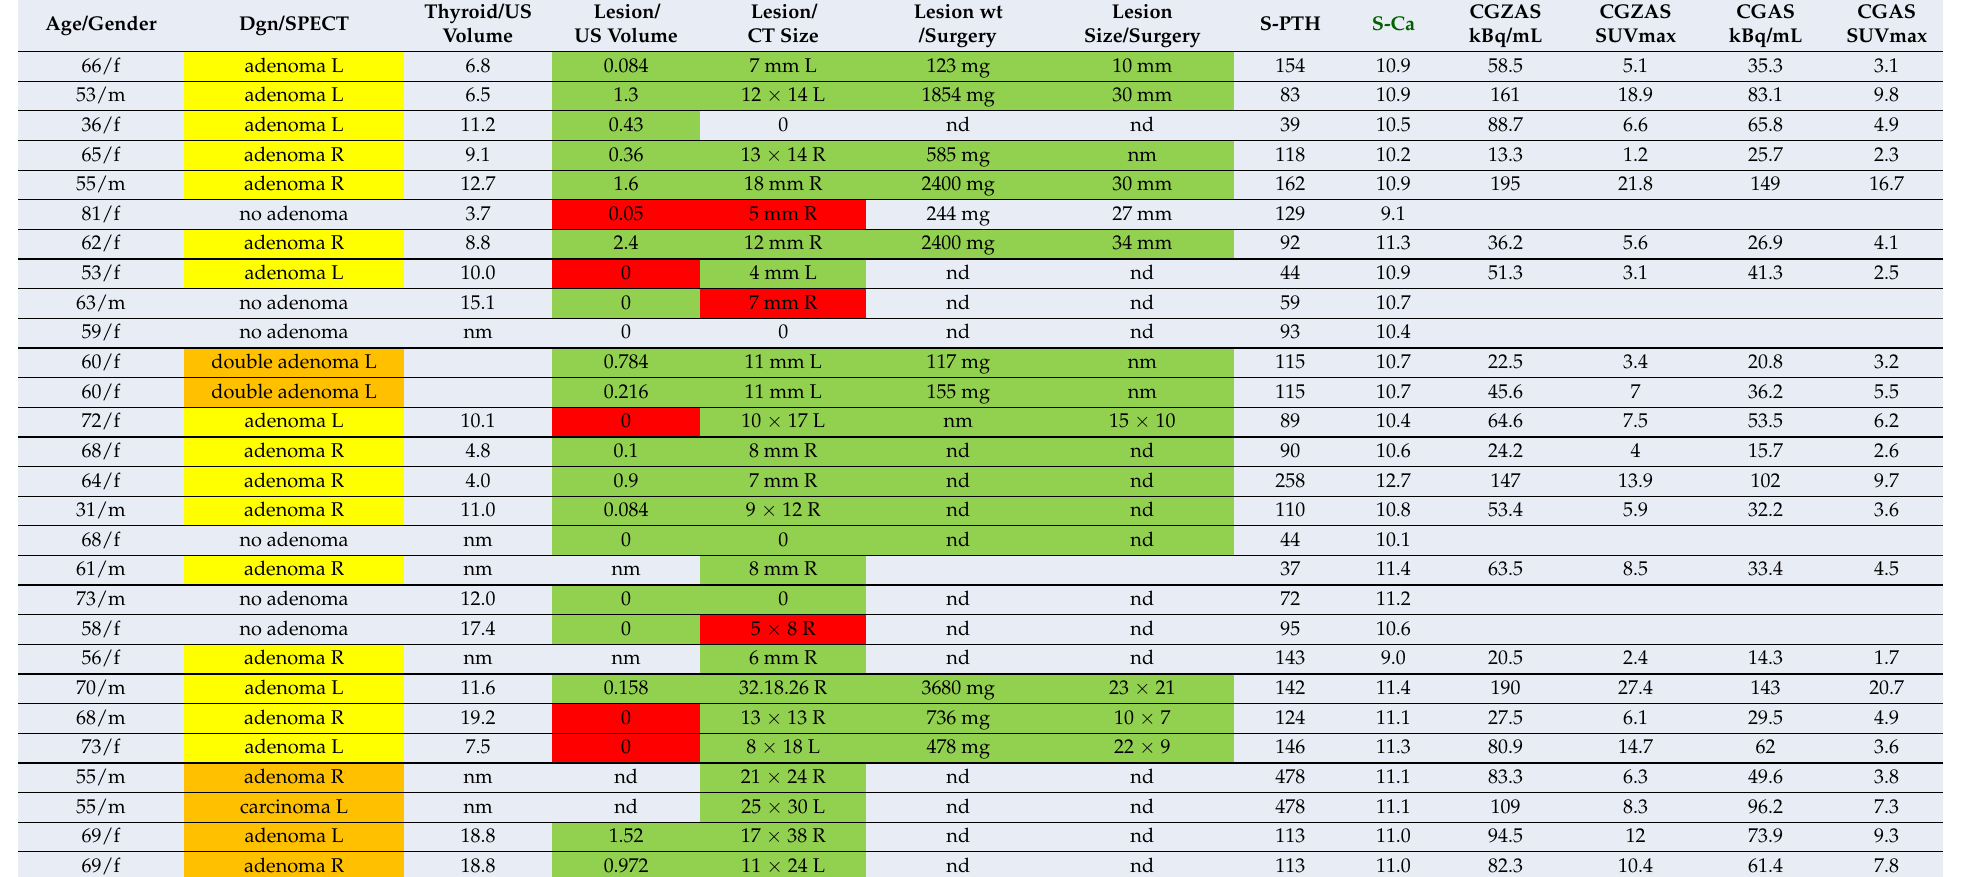
Table 1. Patient characteristics. Age, gender, adenoma (lesion) site (left, right), total thyroid volume (mL), lesion volume in US (mL), lesion size in CT (mm), lesion weight in surgery (mg), lesion size in surgery (mm), S-PTH and S-Ca at the time of imaging diagnosis, CGZAS and CGAS as measured from xSPECT in (kBq/mL) and (SUVmax). Abbreviations: SPECT = single photon emission computed tomography, US = ultrasonography, CT = computed tomography, CGZAS and CGAS (see text), L = left, R = right, nd = not done, nm = not measured. Yellow color refers to an adenoma on SPECT, green color refers to a match in US, CT or surgery and red color to a mismatch in US or CT. Brown colors indicate dual lesions in same